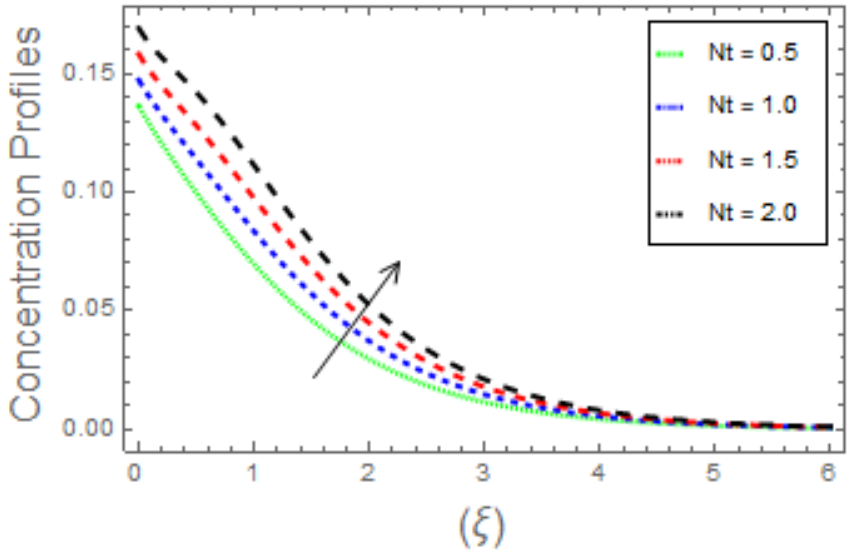
Figure 14. Variation in C due to Nt .